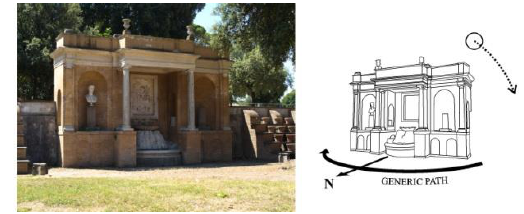
Figure 11. Left, the Celebratory Aedicule of Villa Torlonia; right, orientation of the capture sequences.